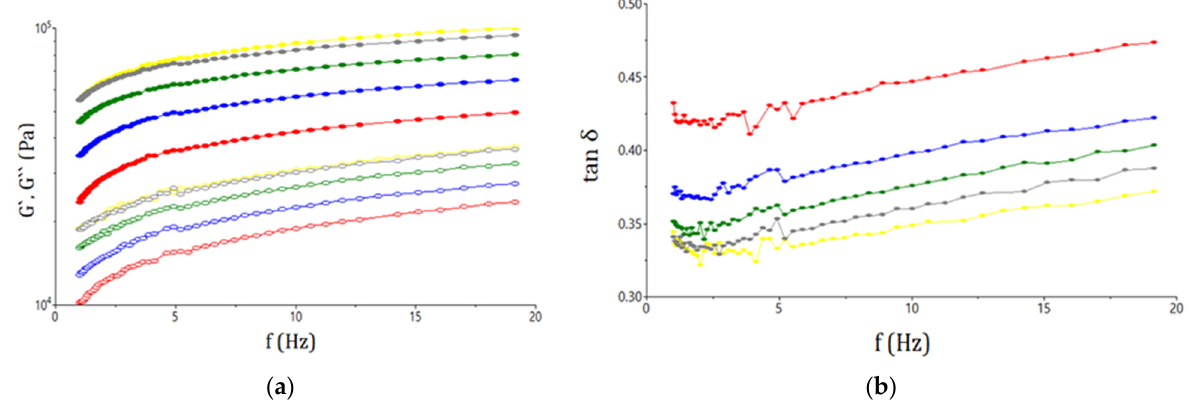
Figure 1. Evaluation with frequency of G’ (open symbols), G” (solid symbols) ( A ) and tan δ ( B ) for the samples with different levels (- ● -0%; - ● -5%; - ● -10%; - ● -15%; - ● -20%) of germinated chickpea flour additions.